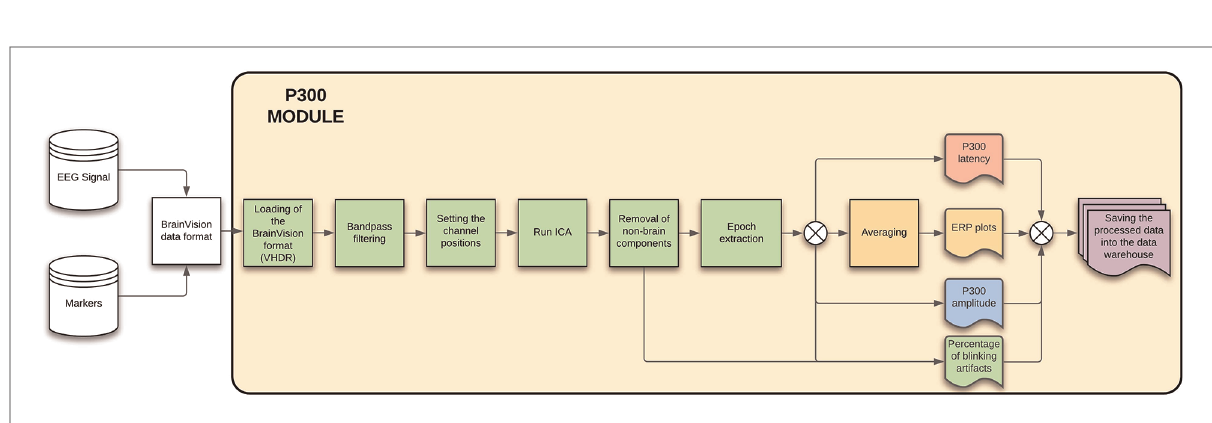
FIGURE 10 P300 module — The fi gure describes each of the steps that will be done automatically by the module, showing also the process inputs and outputs.